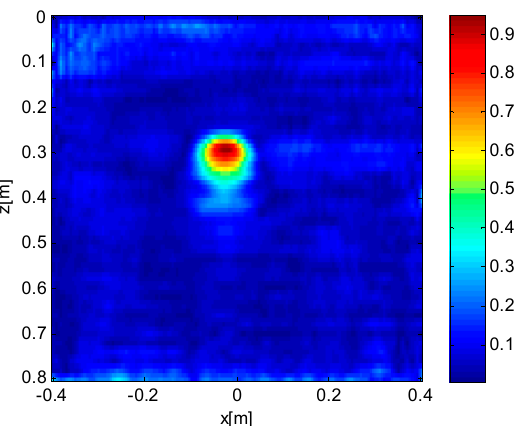
Figure 4. Target reconstruction with an observation domain equal to 1.6 m.